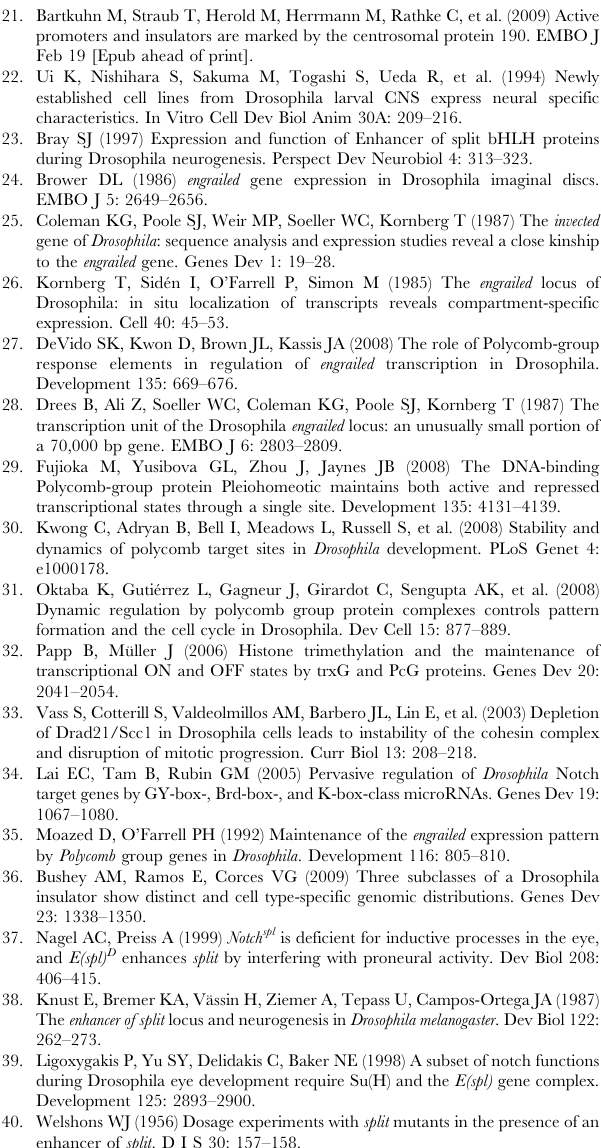
Figure S3 Effects of Rad21 and Nipped-B RNAi on gene expression in BG3 cells. The heat maps show the changes in expression for the most significant biological function gene ontology (GO) categories for the genes that increase in expression (developmental process) and that decrease in expression with cohesin knockdown (translation). The bottom panel shows the heat map for all 959 genes that show significant increases in expression and all 1025 genes that show significant decreases in expression with Rad21 and Nipped-B RNAi knockdown. The significant GO categories for the affected genes are listed in Table S6, with the probe identities in each group. Figure S4 Effects of Rad21 on genes binding both cohesin and RNA polymerase II in BG3 cells. The 804 genes binding